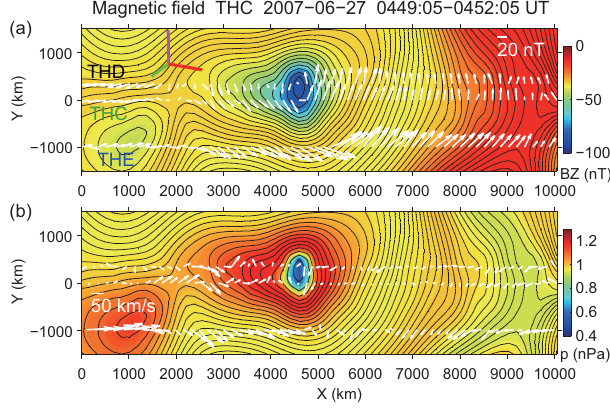
Figure 5. Two-dimensional (2-D) magnetic field and pressure re- covered from the GSR method using the THC data for the same interval as for the 3-D reconstruction. Black lines show the recon- structed transverse field lines, with (a) the axial field component B Z and (b) pressure in colour. White arrows show the projections onto the GSR X-Y plane of the actually measured magnetic fields in panel (a) and ion velocities left over in the HT frame in panel (b) . The GSR axes are in GSM: X = ( − 0 . 0131 , − 0 . 4544 , 0.8907), Y = ( 0 . 9295 , − 0 . 3339 , − 0.1567), and Z = ( 0 . 3686 , 0 . 8258 , 0 . 4268). The magenta, green, and red bars in panel (a) are the GSR X-Y projections of the GSM x , y , and z axes,